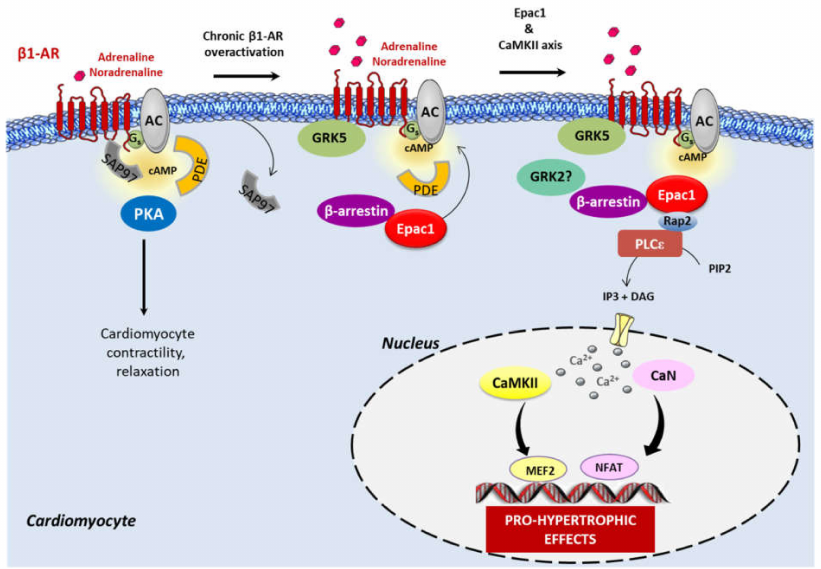
Figure 1. β 1-AR signaling during chronic adrenergic stress. Acute stimulation of β 1-AR induces cAMP production through the adenylyl cyclase (AC) and protein kinase (PKA) activation to regulate cardiomyocyte contraction and relax- ation. Phosphodiesterases (PDE) regulate cAMP diffusion and concentration. In basal conditions, Epac1 constitutively interacts with β -arrestin in the cytosol of cardiomyocytes. Under the sustained activation of β 1-AR, there is a switch of physiological cAMP-PKA signaling to cAMP-Epac1 pro-hypertrophic signaling. Mechanistically, the synapse-associated protein 97 (SAP97), a scaffold protein, is released from β 1-AR and facilitates receptor signaling to the detrimental Epac1- Ca 2+ /calmodulin-dependent protein kinase II (CaMKII) axis. GRK5, and not GRK2, enhances agonist-induced dissociation of SAP97 from β 1-AR. The complex β -arrestin–Epac1 is then recruited to the plasma membrane where Epac1 interacts with its effector, Rap2, which in turn stimulates the phospholipase C ε (PLC ε ). The subsequent production of 1,4,5-trisphosphate (IP3) and IP3-receptor stimulation induces Ca 2+ elevation, which activates the Ca 2+ -sensitive proteins, CaMKII and calcineurin (CaN), and their downstream targets, the pro-hypertrophic transcription factors, myocyte enhancer factor 2 (MEF2), and the nuclear factor of activated T cells (NFAT). The role of GRK2 in Epac1 complex formation at the β 1-AR has yet to be